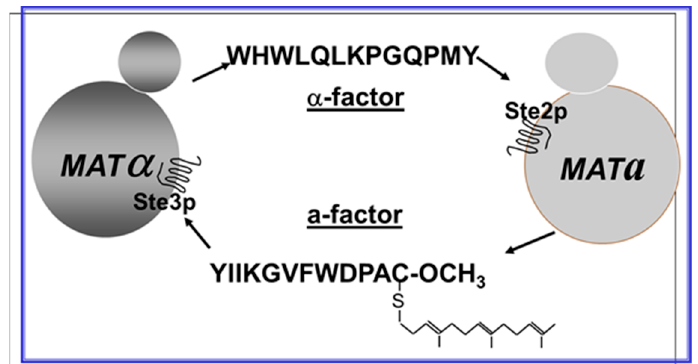
Figure 1. A diagrammatic representation of the pheromones ( α -factor and a -factor) mediating the sexual conjugation of Saccharomyces cerevisiae haploid cells of opposite mating types ( MAT α and MAT a ). MAT α and MAT a cells secrete their cognate pheromones to prepare their opposite mating type for mating (conjugation), resulting in a diploid cell. Ste2p and Ste3p are the membrane-bound receptors on MAT a and MAT α cells, respectively, that recognize their bound pheromones to arrest the recipient cell in the G1 phase of the cell cycle in preparation for conjugation. Pheromones and hormones perform physiologically equivalent functions; pheromones act between individuals of the same species, whereas hormones are produced and act within an individual.